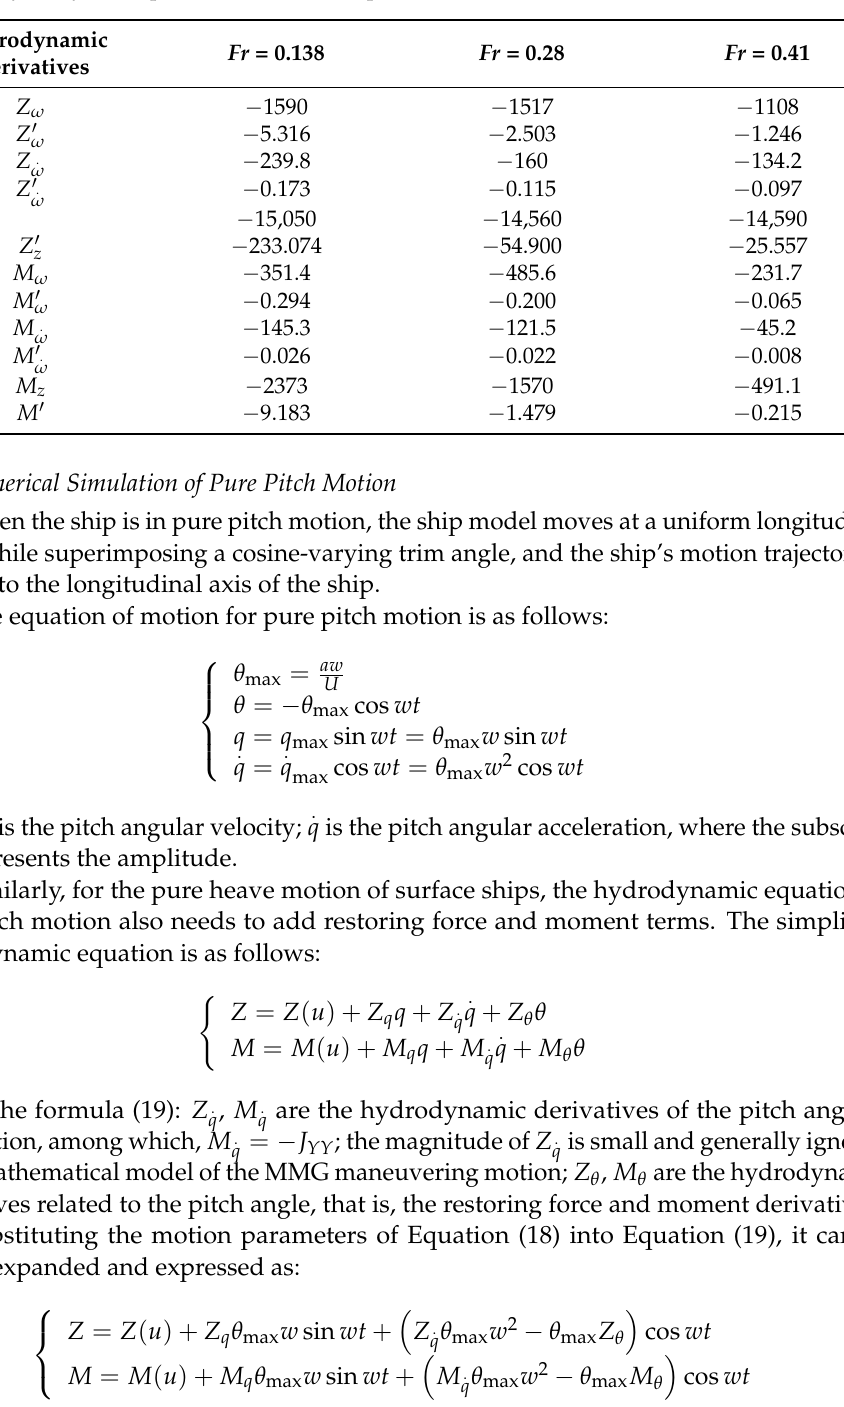
Table 9. Hydrodynamic parameters related to pure heave